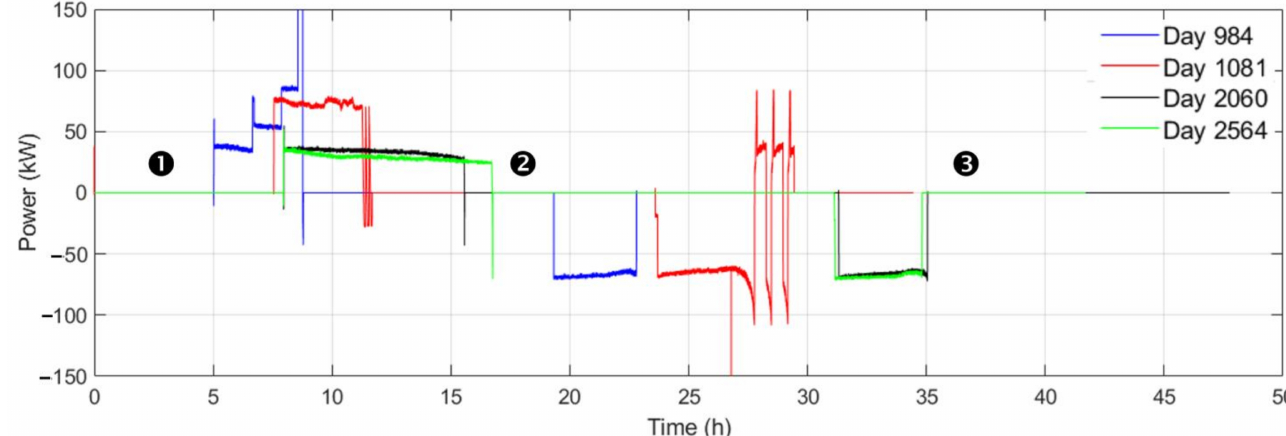
Figure 4. Power vs. time curves for the four iterations of the HNEI performance